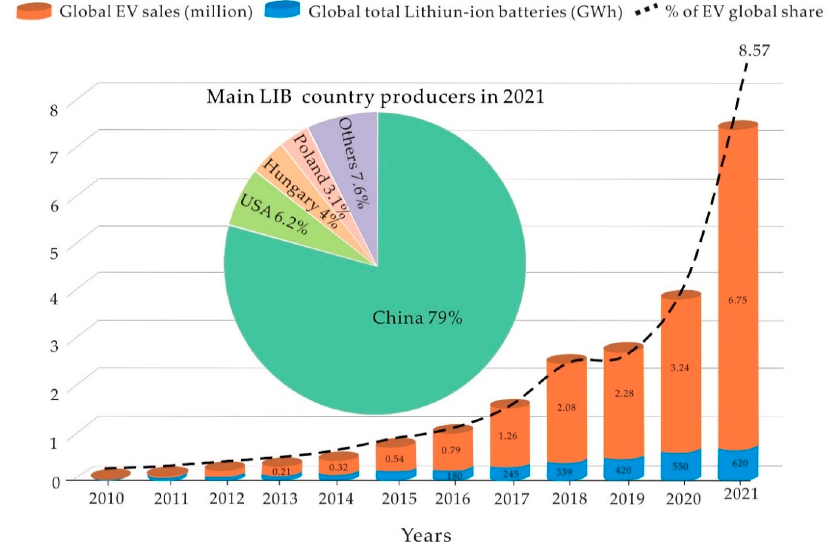
Figure 10. The trend of global lithium-ion batteries and electric vehicles in the last decade. Data from [72,83,87].